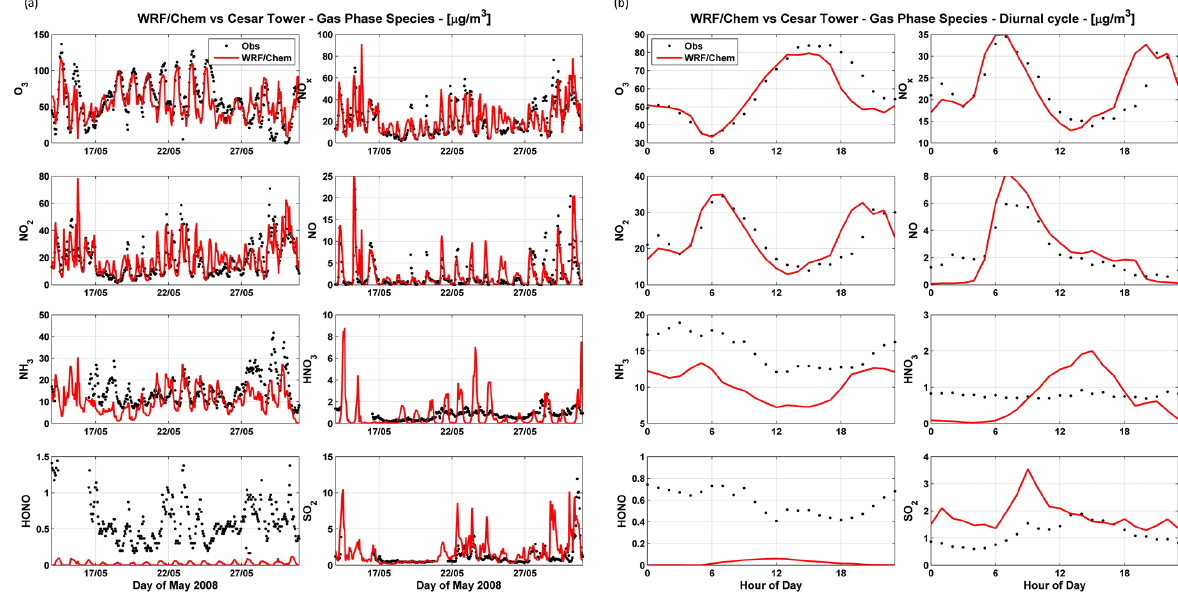
Figure 4. Observed and simulated time series of gas-phase species (a) and their average diurnal cycle (b) , at Cabauw Zijdeweg EMEP station